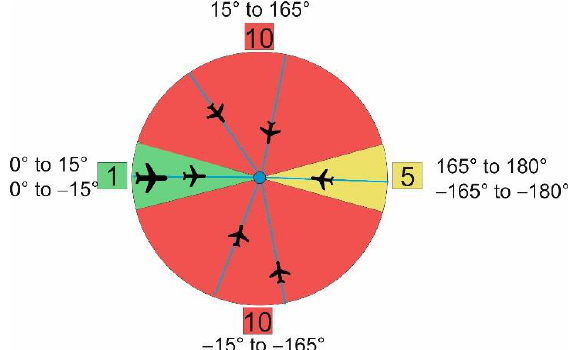
Figure 7. Definition of similar (green), other (red) and opposite (yellow) direction between flights.